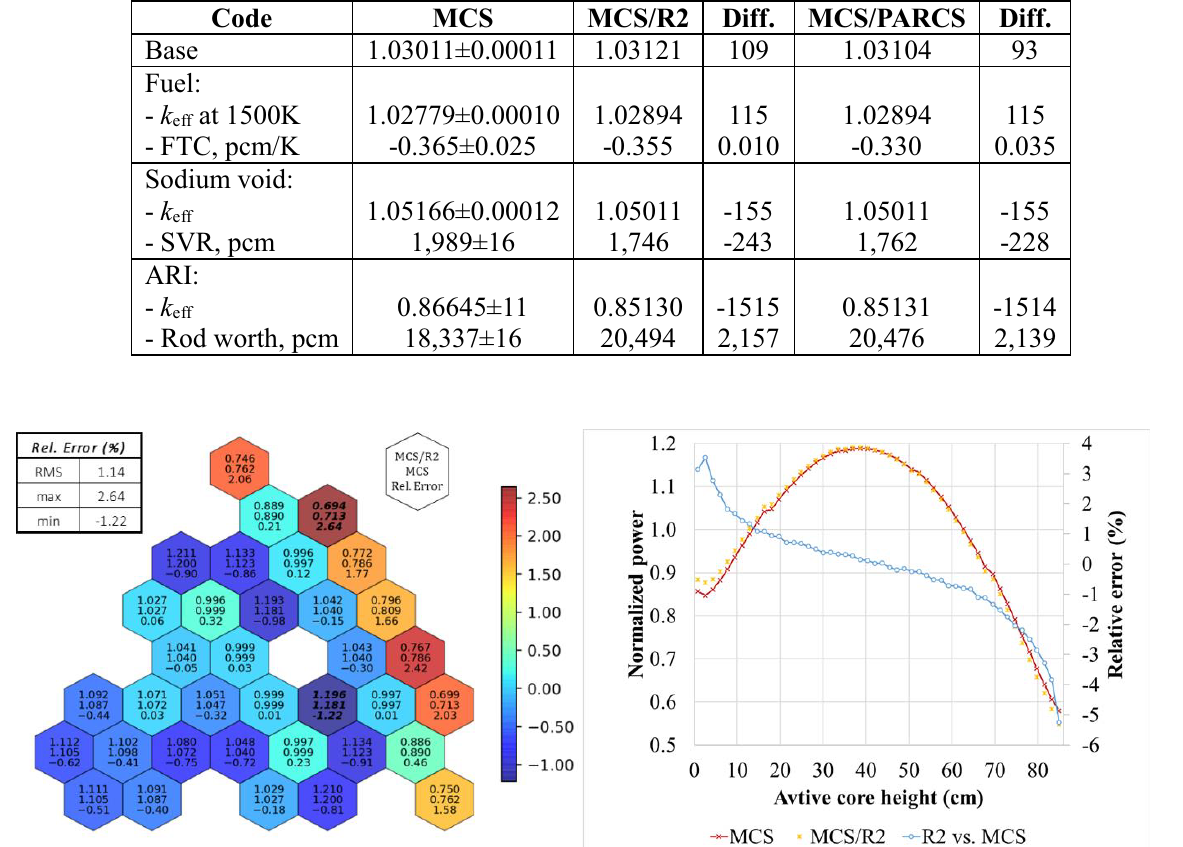
, MCS/R2, MCS/PARCS and MCS. eff